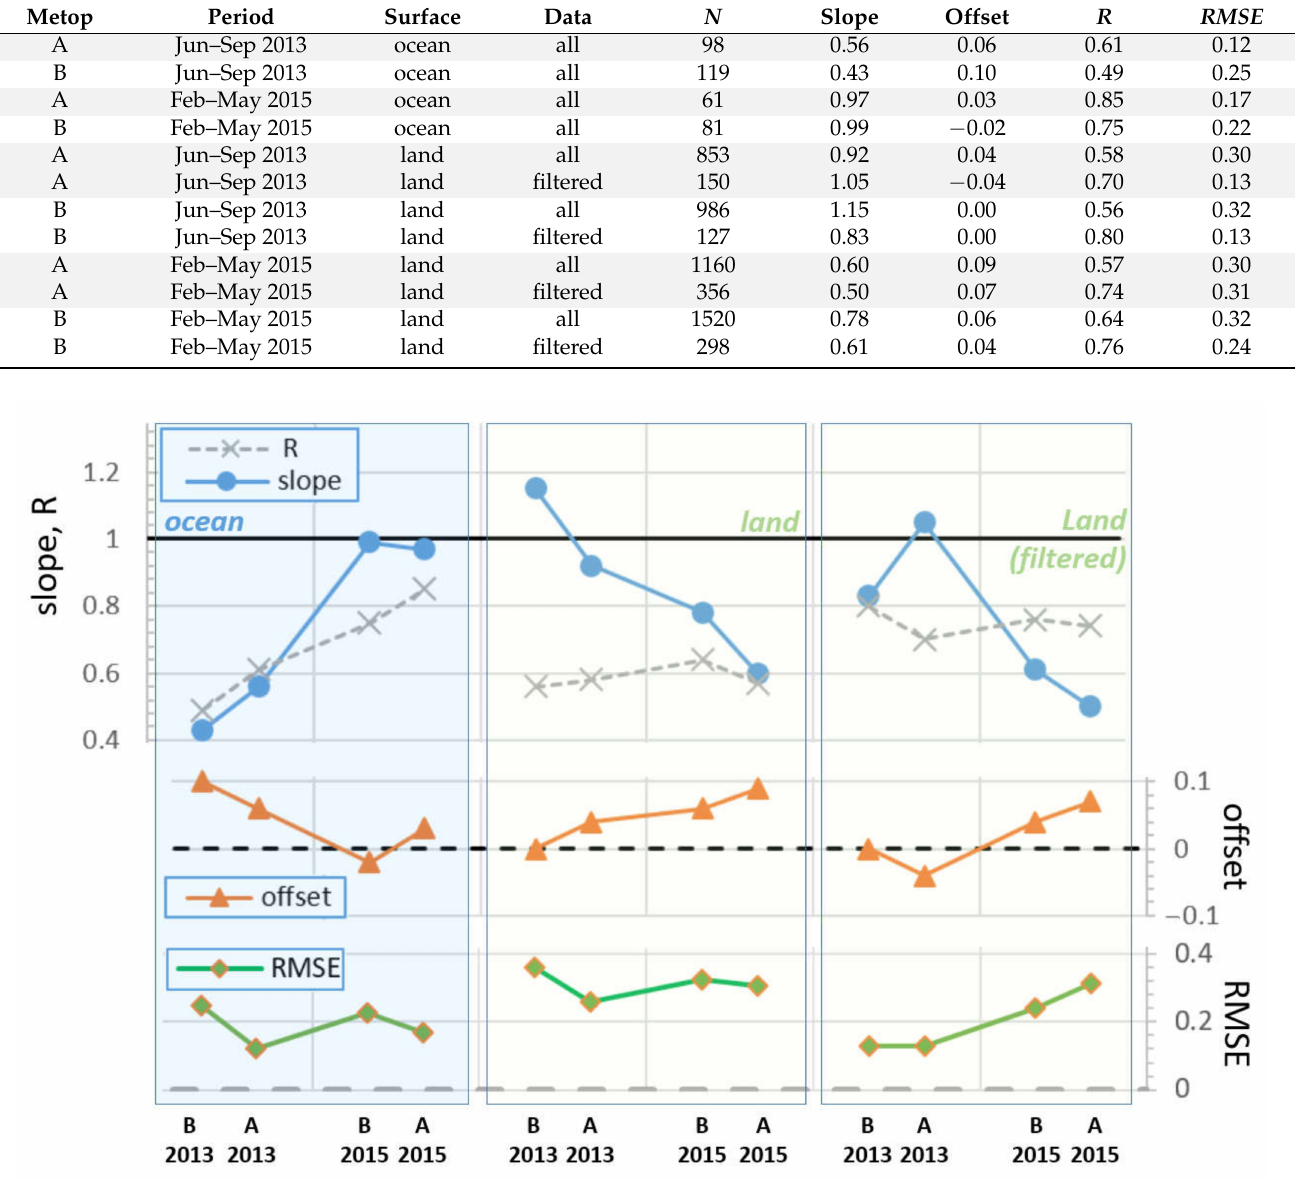
Table 6. PMAp AOD against AERONET AOD: summary of the performance for both Metop –A (in grey) and –B, for the two reference periods in June–September 2013 and February–May 2015, and over land or ocean. Filtered data refers to cloud-free retrieval cases, excluding bright surface conditions. Statistics provided are the number of matchups ( N ), the slope, offset, correlation coefficient ( R ), and root mean square error ( RMSE ) of the linear regressions.